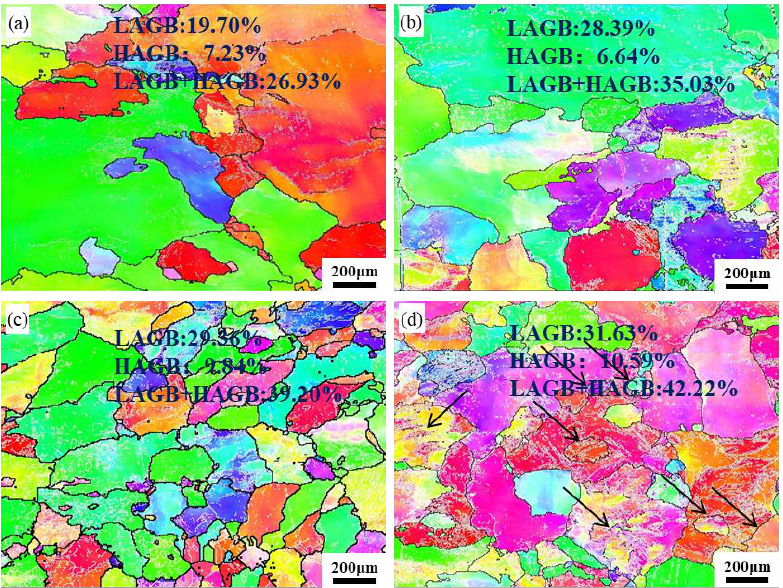
Figure 11. EBSD maps of the W-state alloy after a tensile strain of 0.12 at ( a ) 298 K, ( b ) 218 K, ( c ) 138 K, and ( d ) 77 K.